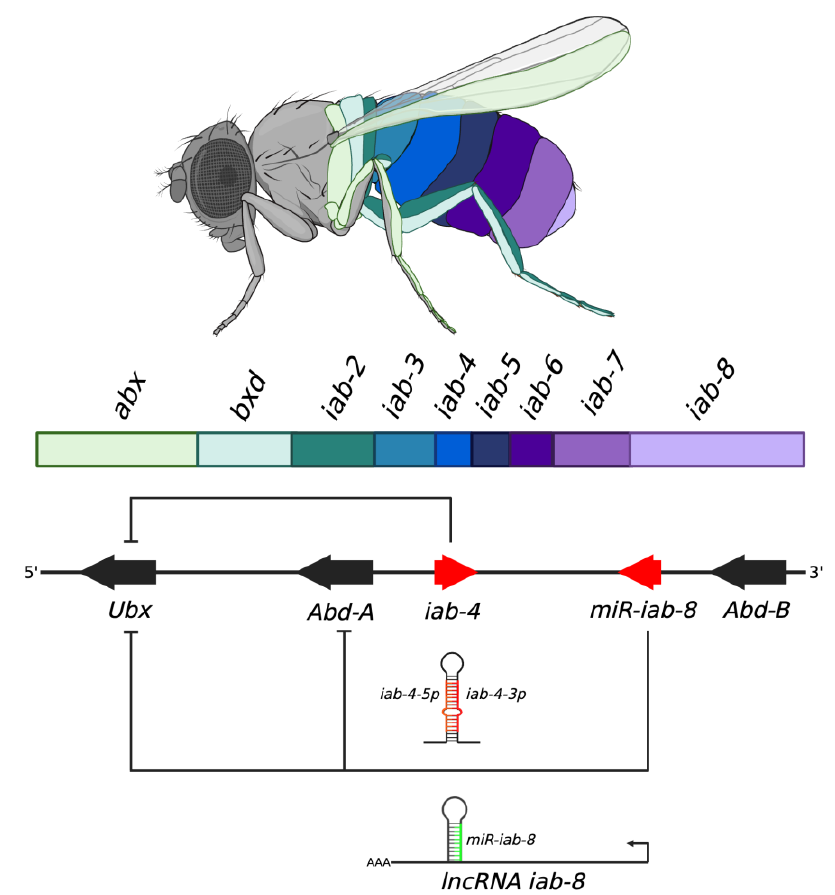
Figure 3. The bithorax complex in Drosophila . The nine cis-regulatory regions of the BX-C are shown in order ( abx, bxd, iab-2–iab8 ) and color-coded to the regions they regulate in the developing fly. The homeotic genes Ubx , Abd-A, and Abd-B are shown in their respective positions in the cluster. The miRNAs iab-4 and miR-iab-8 are indicated by the red arrows. The iab-4 miRNAs regulate Ubx, and miR-iab- 8 regulates Ubx and Abd-A . The iab-4 hairpin containing both the iab-4-5p and iab-4-3p miRNAs (red) and the lncRNA iab-8 containing the miR-iab-8 miRNA hairpin (green) are shown. BX-C DNA labeled 5′-3′ based on the orientation of the sense strand. Adapted from Refs. [136,140].